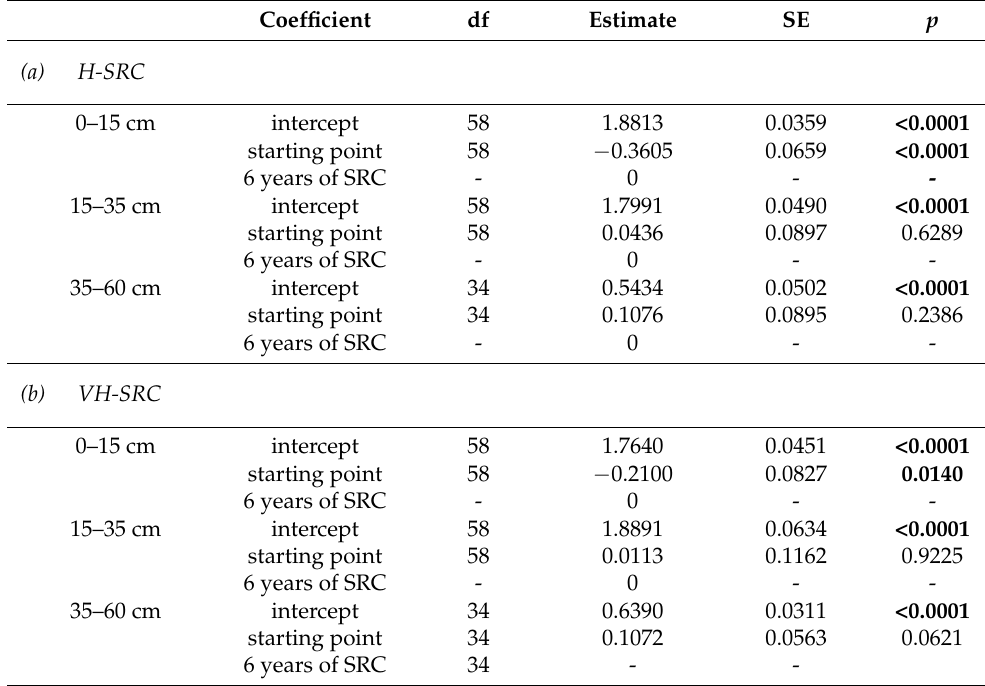
Table 2. Effect of 6 years of (a) high-density (H)-short rotation coppice (SRC) and (b) very-high- density (VH)-SRC on SOC: coefficient estimates and their standard error of the fixed effect (duration of SRC permanence: starting point and 6 years of SRC). The response variable is SOC stock (kg m − 2 ) for the first two layers (0–15 cm and 15–35 cm) and SOC content (%) for the third one. Significant differences ( p < 0.05) are in